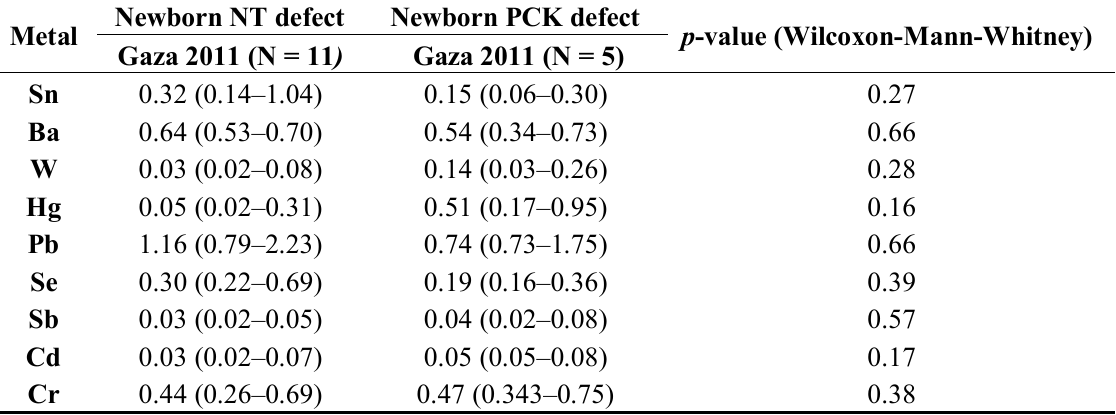
Table 2. Comparison of metal load (ppm) between children with neural tube defects (NT, N=11) and children with polycystic kidney defect (PCK, N=5), the two single body compartment defects most frequent among our patients